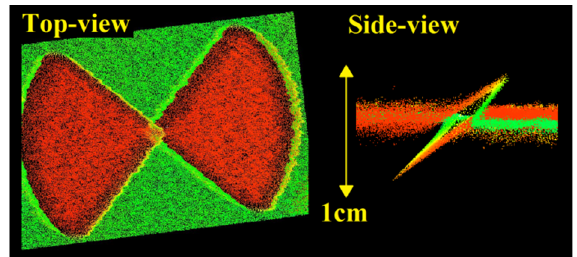
Figure 5. Systematic point displacement on the edges of the black and white target Figure 5 . Systematic point displacement on the edges of the black and white target regions.